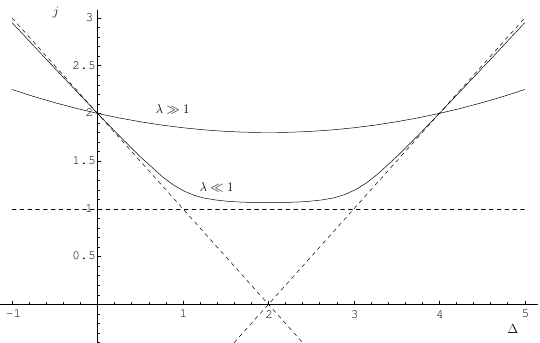
Figure 9. Schematic form of the (cid:1) strong coupling ( (cid:21)